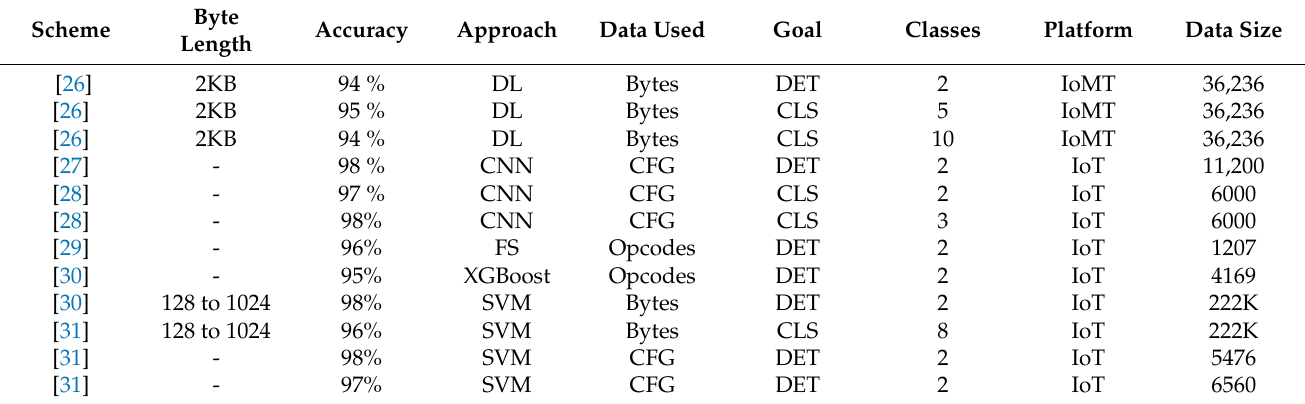
Table 1. Comparison of various schemes’ security, classification and detection approach.